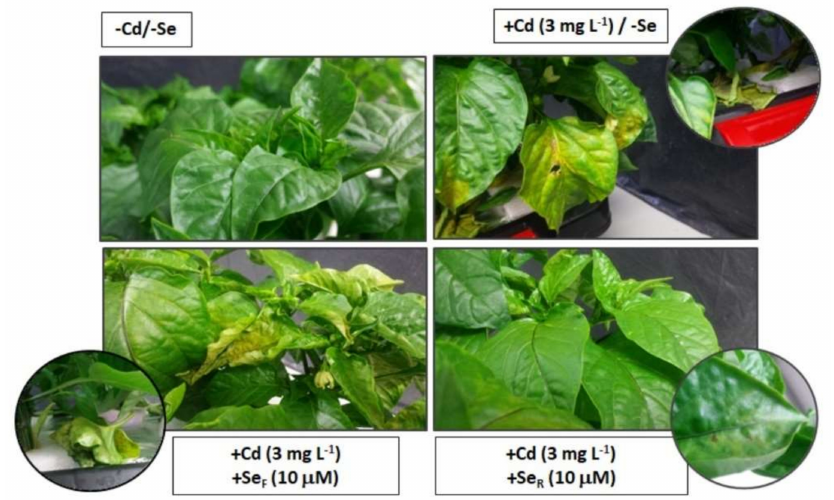
Figure 6. Image of the visual symptoms observed in the pepper leaves from the different treatments applied at the end of the